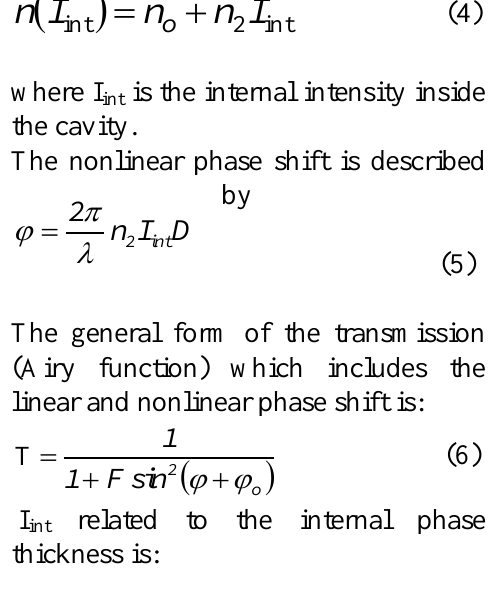
Fig.1: Fabry-Perot interferometer of length (D) and mirror reflectivity (R and I are the incident and transmitted T intensities